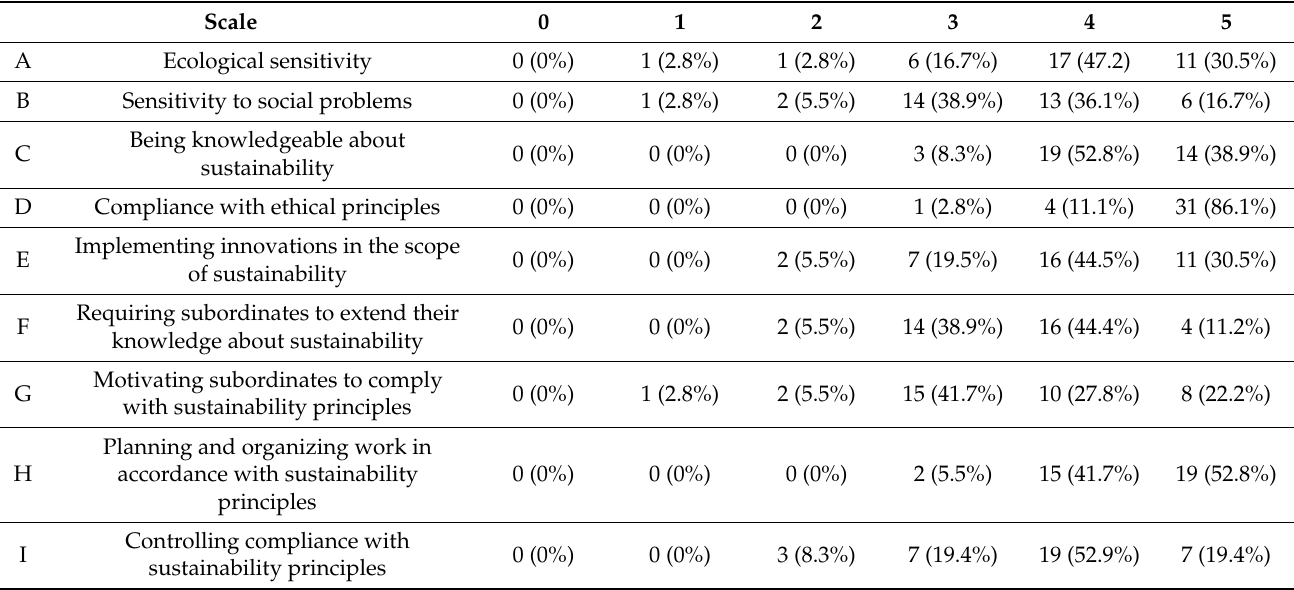
Table 2. Number of answers regarding a sustainable manager’s profile (managers in